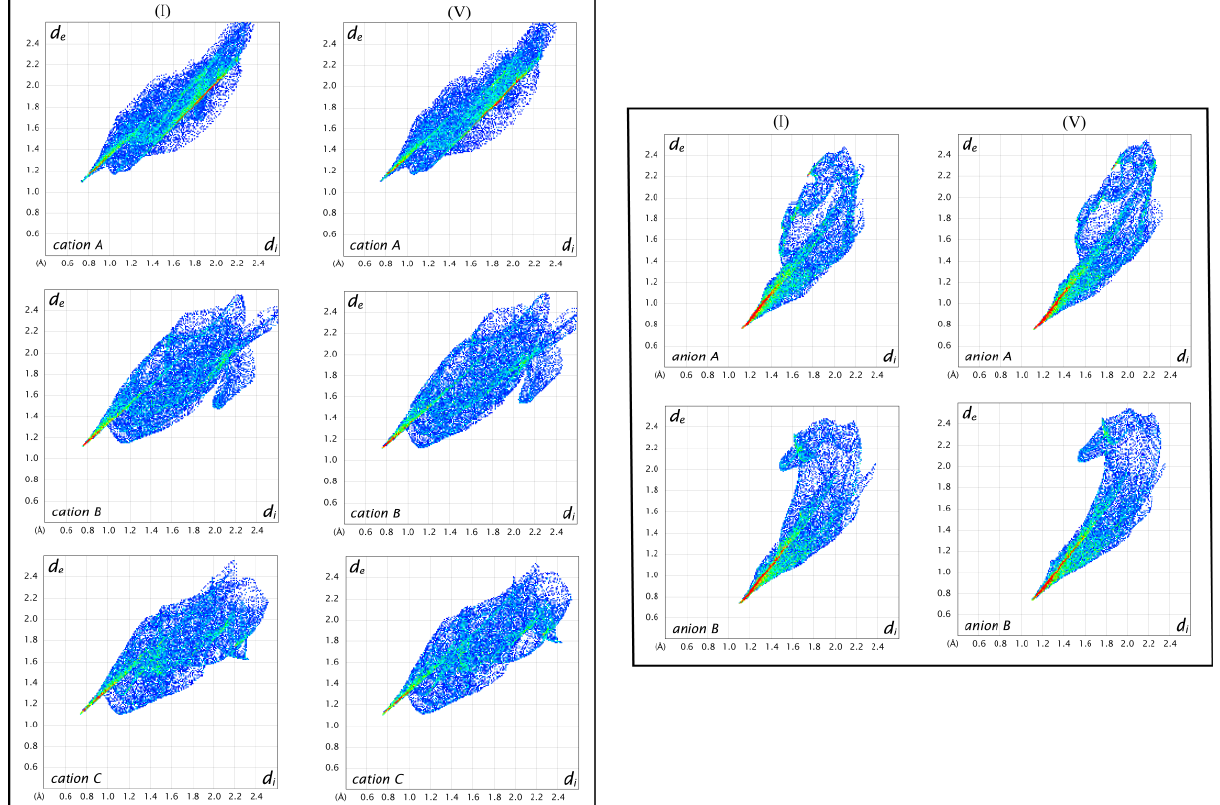
Figure 5. Two-dimensional fingerprint plots ( d i , d e ) of the Hirshfeld surface of various intermolecular interactions. Left columns for bis(guanidinium) trioxofluorophosphate—compound ( I ); right columns for bis(guanidinium) phosphite—compound (V). Cation A occupies the general position. The Figure was prepared by Crystal Explorer software [20].